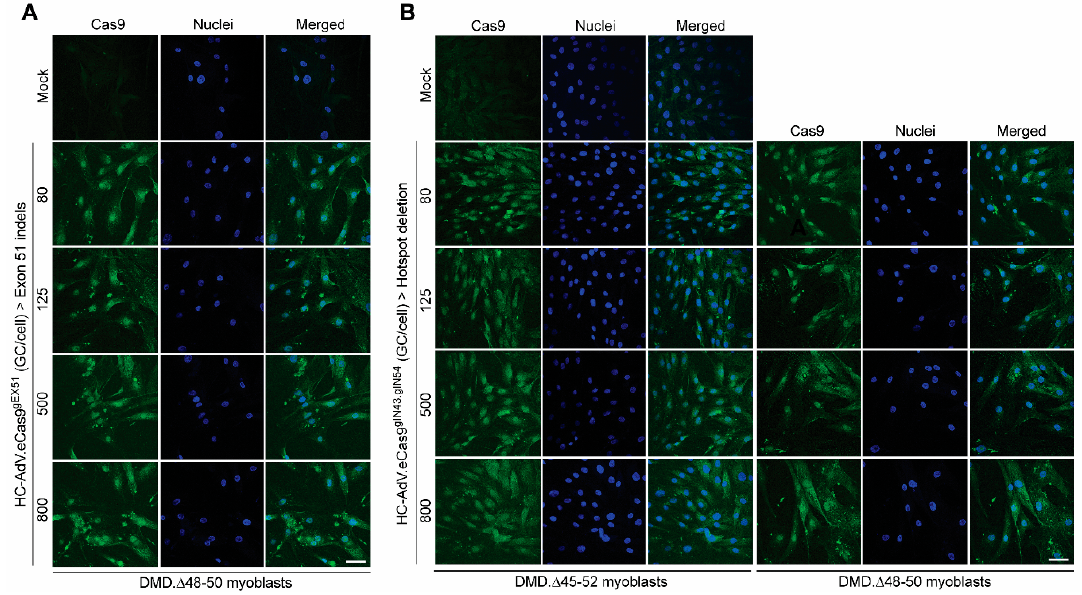
Figure 5. Detection of eCas9.4NLS expression in DMD myoblasts after “all-in-one” HC-AdV transduction of single and dual RGNs. ( A ) Immunofluorescence microscopy analysis on DMD. ∆ 48–50 myoblasts transduced with CD46-targeting HC-AdV particles encoding RGN-targeting DMD exon 51. ( B ) Immunofluorescence microscopy analysis on DMD. ∆ 45–52 and DMD. ∆ 48–50 myoblasts transduced with CD46-targeting HC-AdV particles co-expressing RGNs specific for sequences in DMD introns 43 and 54. The confocal microscopy analyses were carried out at 3 days post-transduction in the presence of the DNA dye DAPI (Nuclei staining). Mock-transduced cells served as negative controls. The vector genome copies per cell (GC / cell) applied are indicated. Magnification bar in both panels corresponds to 50 µ